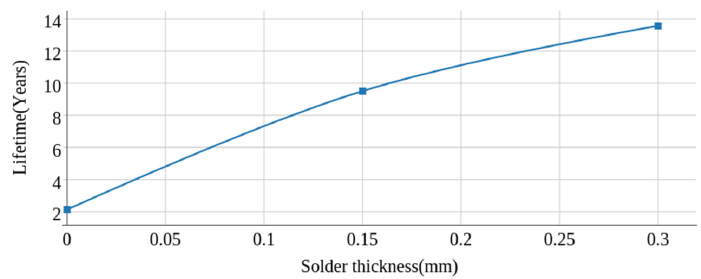
Figure 3. The effect of solder thickness on the lifetime of an IGBT module.